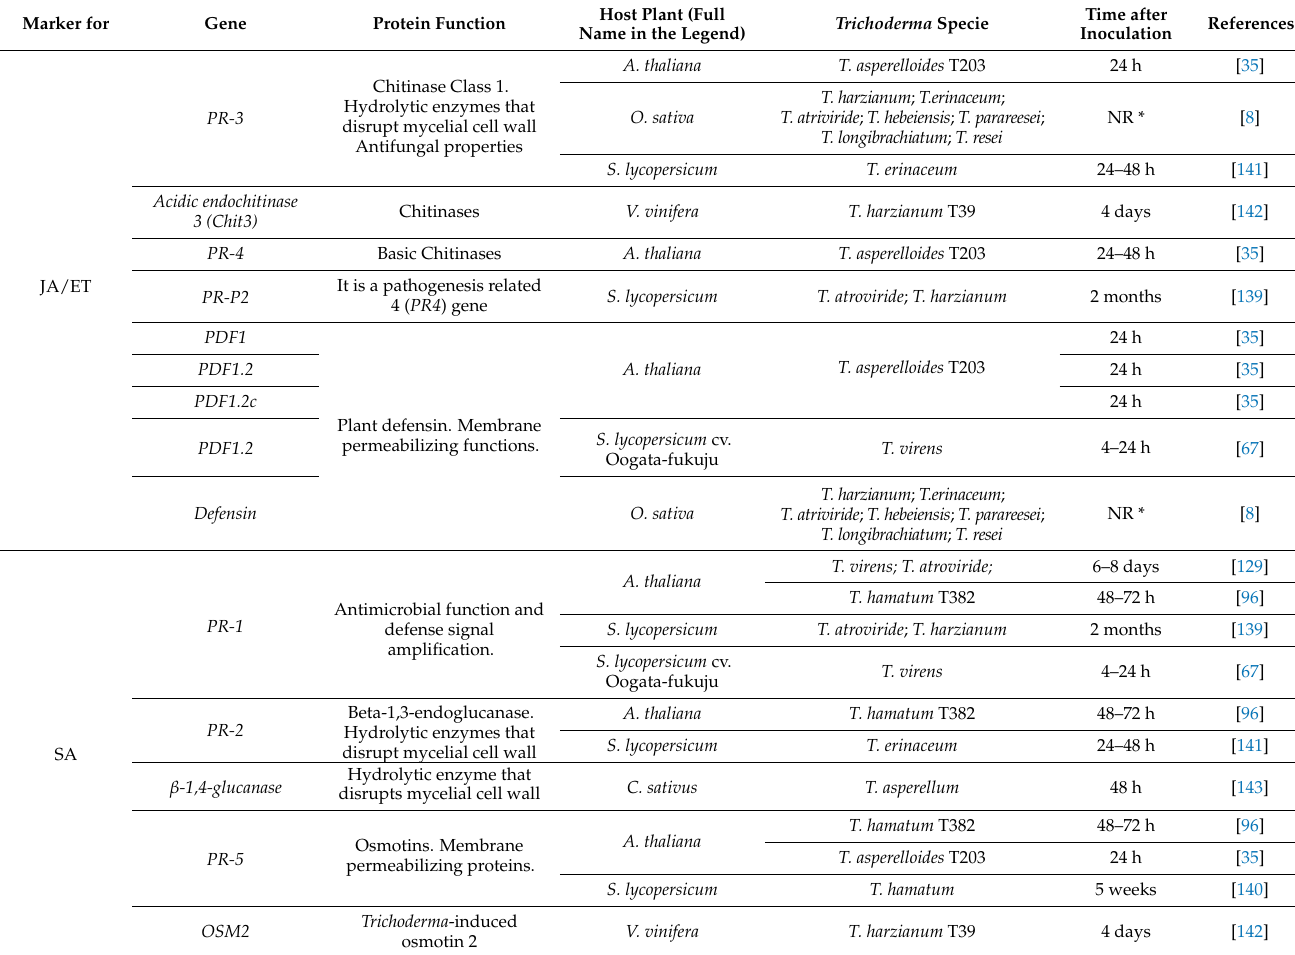
Table 2. Induction of Pathogenesis Related (PR) genes expression by Trichoderma